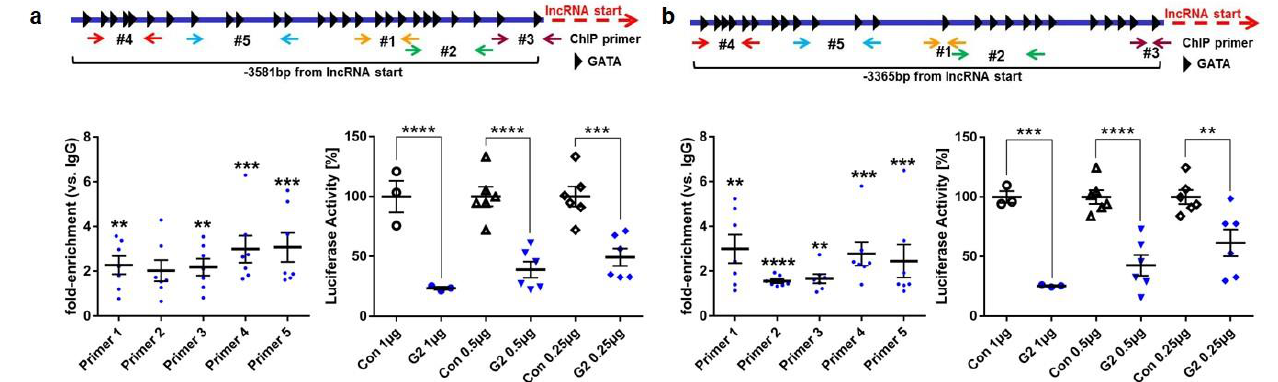
Figure 6. The putative promoter regions of GADLOR1 and 2 are bound and suppressed by GATA2. ( a , b ) Scheme of promoters of GADLOR1 and 2; potential GATA binding sites and primers for ChIP are shown. Below, left: Anti-myc ChIP for binding of myc-GATA2 to promoter regions of GADLOR1 ( a ) and 2 ( b ). Below, right: Luciferase activity after co-transfection with pGADLOR1-Luc or pGADLOR2-Luc and GATA2 or control plasmid. Data are mean ± sem; the number of biological replicates is shown in graphs; * p < 0.05, ** p < 0.01, *** p < 0.001, **** p < 0.0001.